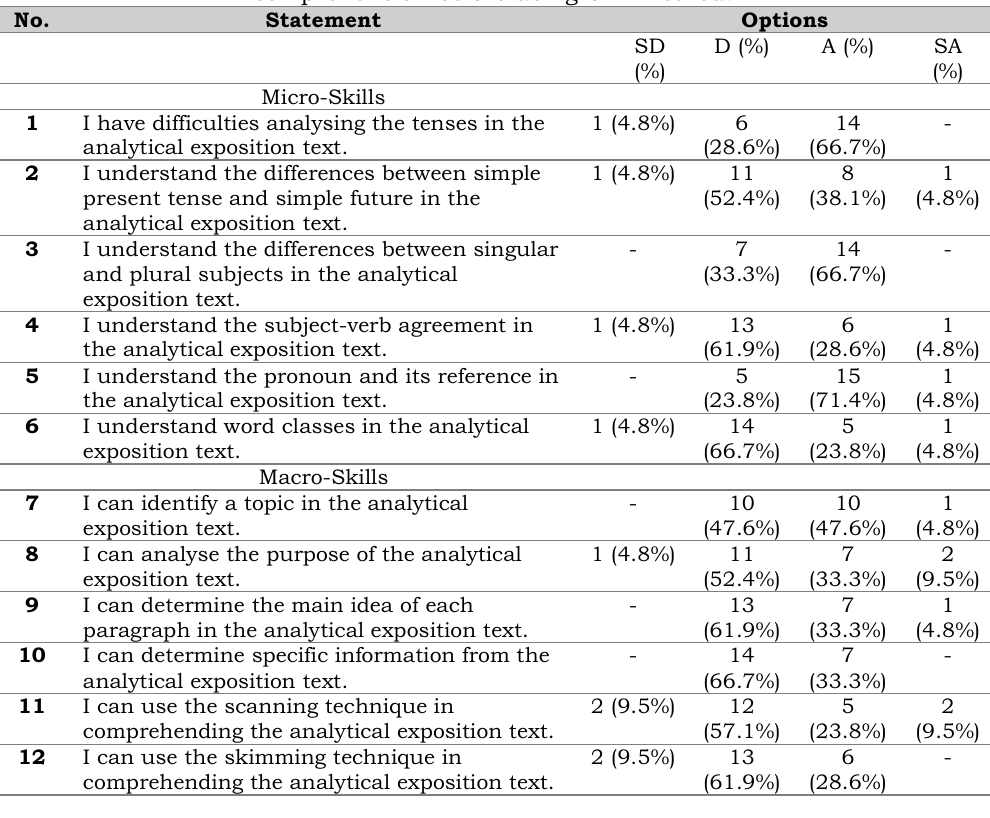
Table 1. Recapitulation of students’ micro-skills and macro-skills of reading comprehension before using CLT